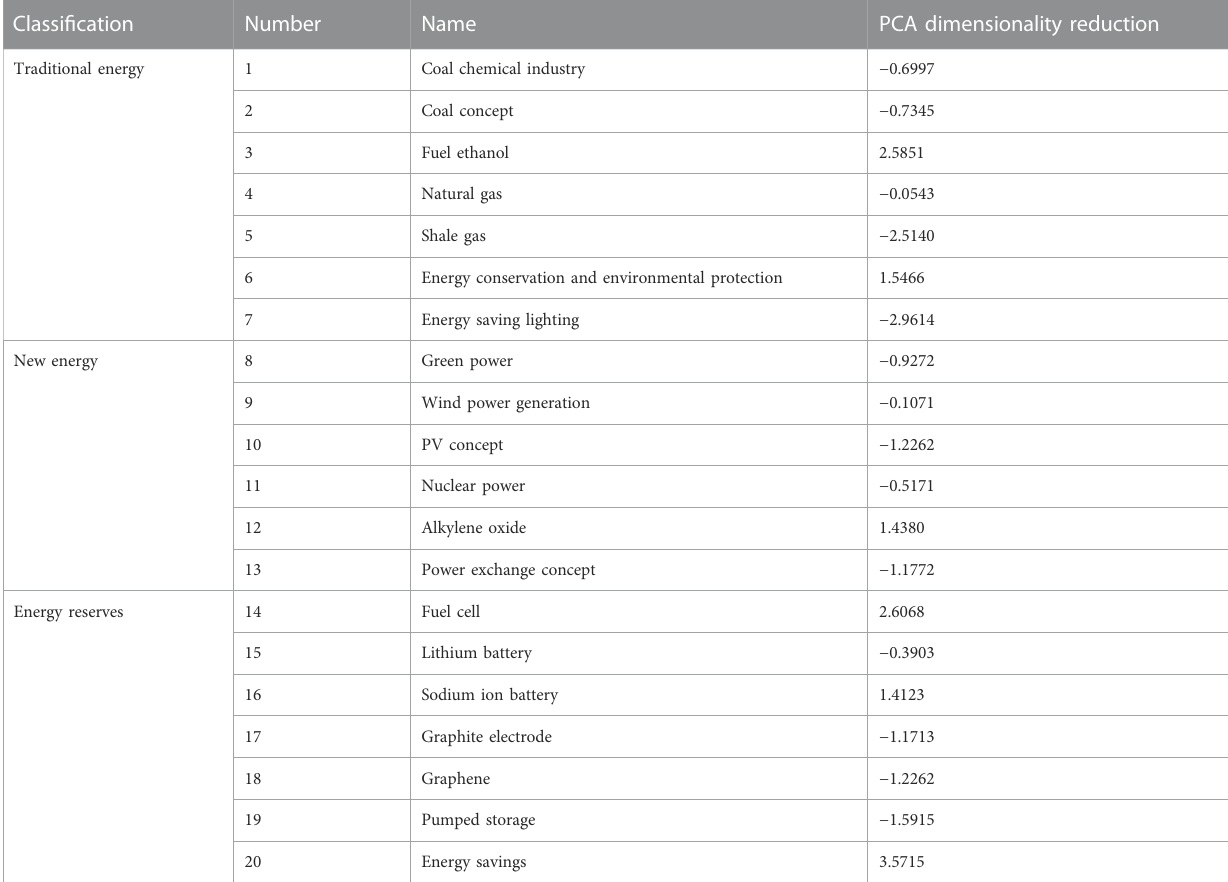
TABLE 6 PCA data dimensionality reduction result.